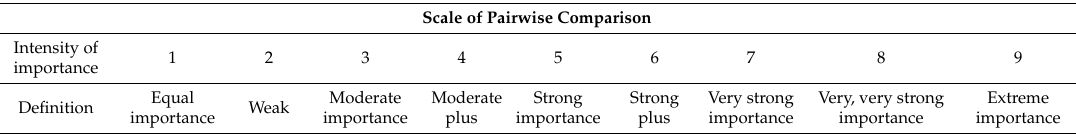
Table A1. Questionnaire/ Scale of Pairwise Comparison.